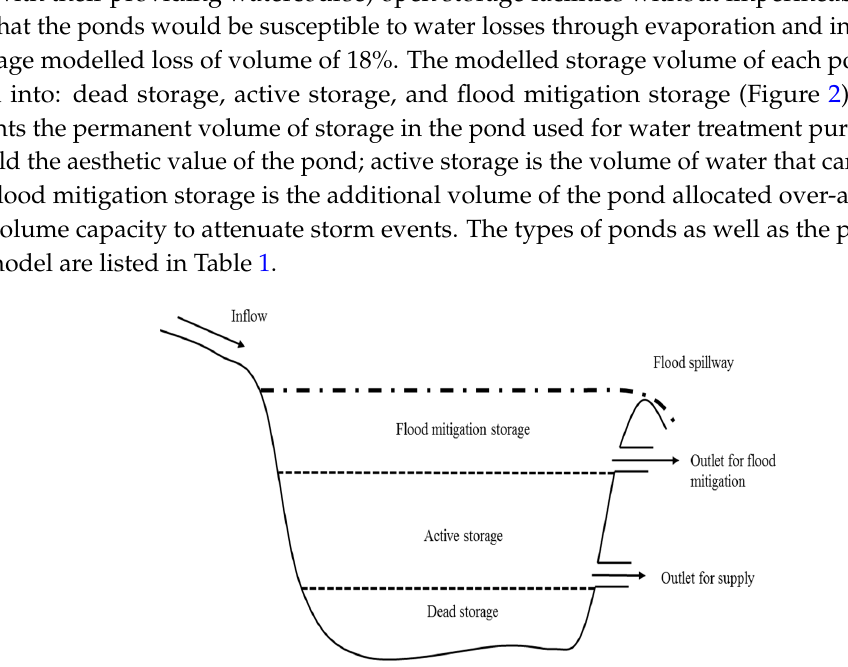
Figure 2. Conceptual design of an open storage stormwater harvesting system (After Mitchell et al. [5]). Table 1. Description of the existing stormwater ponds in the Diep River sub-catchment.